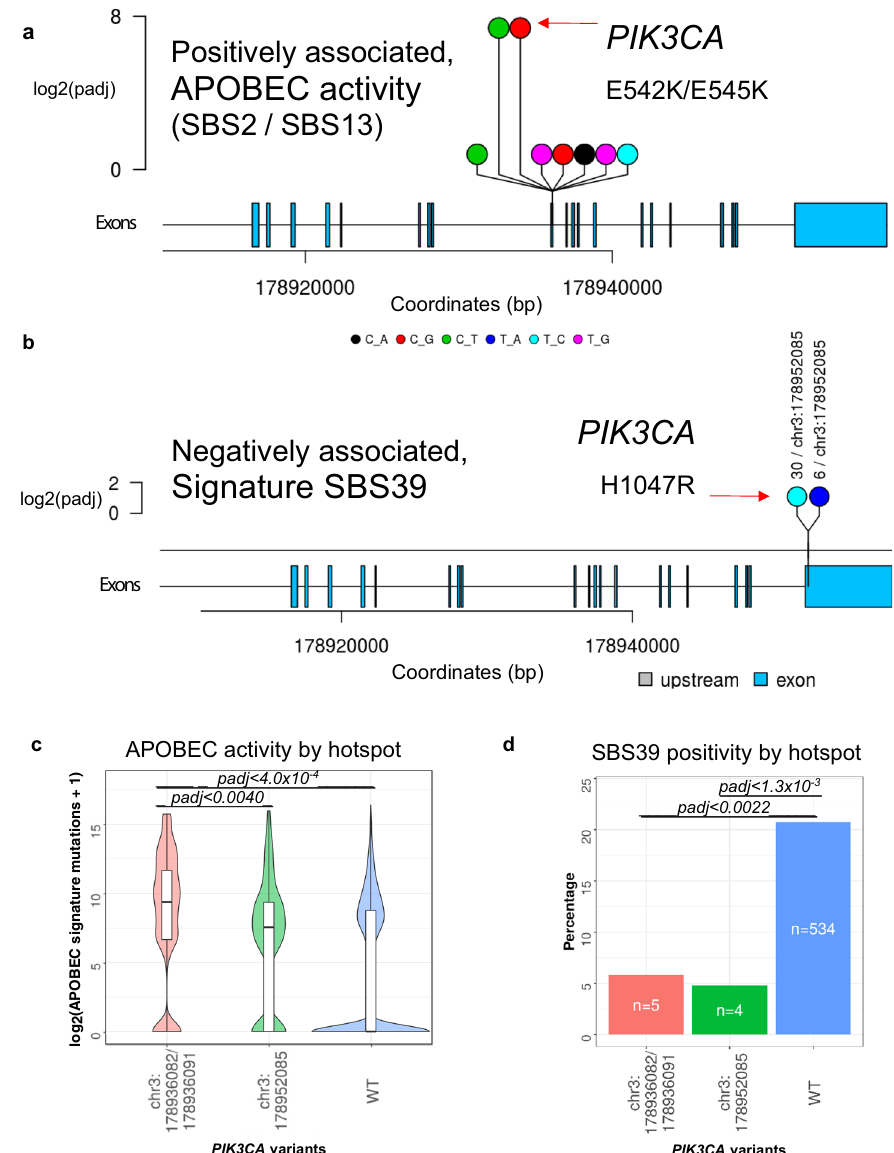
Fig. 4 Relationship between PIK3CA hotspot mutations and mutational signature exposures. a PIK3CA hotspot on exon 12 positively associated with APOBEC signatures (SBS2/SBS13). b PIK3CA hotspot on exon 1 negatively associated with signature SBS39. c Violin-plot comparing APOBEC signature exposures (SBS2 + SBS13) on PIK3CA hotspots, signi fi cance between the wild-type (WT) group and the mutated group was tested by a two-sided Wilcoxon rank-sum test ( p < 2.0 × 10 − 4 and p < 0.0020). The box indicates the 25th and 75th percentiles with the median highlighted by a black line, whiskers extend to 1.5 times the interquartile range from the 25th and 75th percentiles, and polygons represent density estimates of data. d Bar-plot comparing the binary status of signature SBS39 exposures in tumors carrying different hotspot mutations. Tumors with more than 5% normalized signature exposures were considered positive, signi fi cance between the wild-type (WT) group and the mutated groups were evaluated by a two-sided chi-square test and corrected for multiple testing according to Bonferroni ( p adj <1.3 × 10 − 3 and 0.0022). Source data are provided in Supplementary Data can bene fi t driver discovery by two aspects: repeated measure- ments by surrogate signatures and extraction of missing information by so far disregarded signatures.